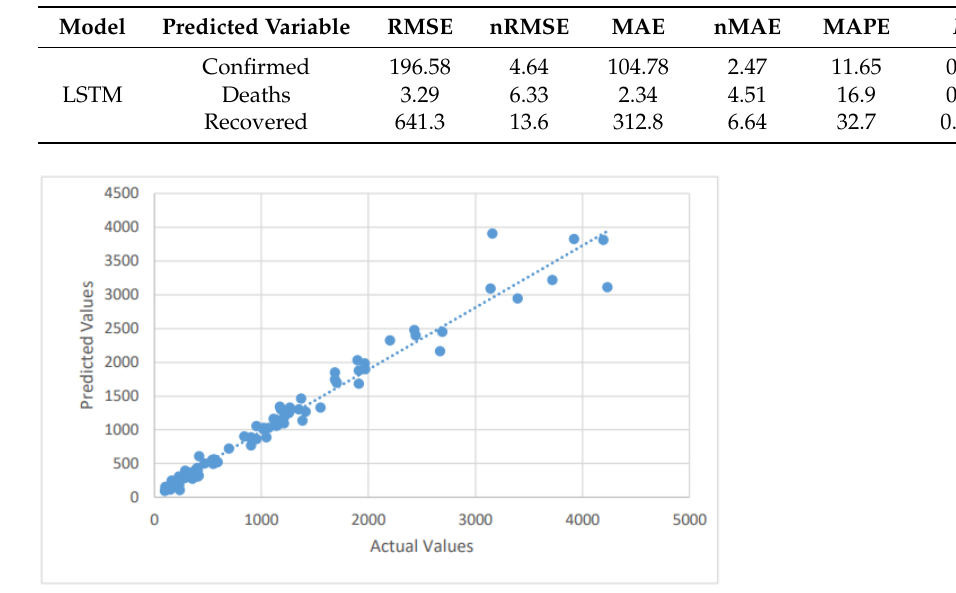
Table 1. Performance evaluation of the test dataset forecasting using the LSTM model.